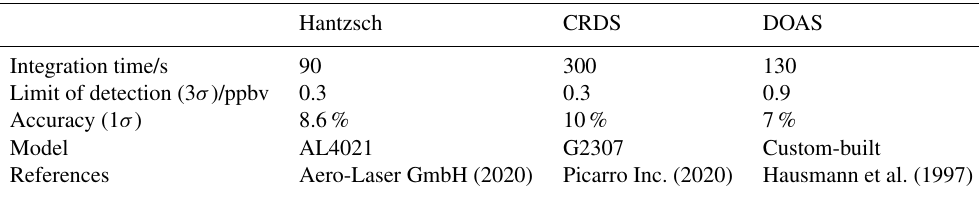
Table 1. Specifications of the Hantzsch, CRDS and DOAS instruments used in this work, as stated by the manufacturer or reported in previous